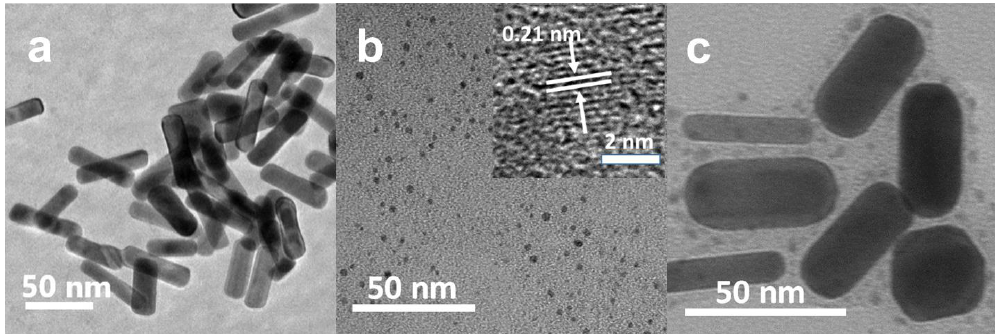
Figure 1. TEM images of GNRs ( a ), CDs ( b ) and GNR-PEG-CD ( c ), inset of (b) is high-resolution (HR) TEM image of CDs.